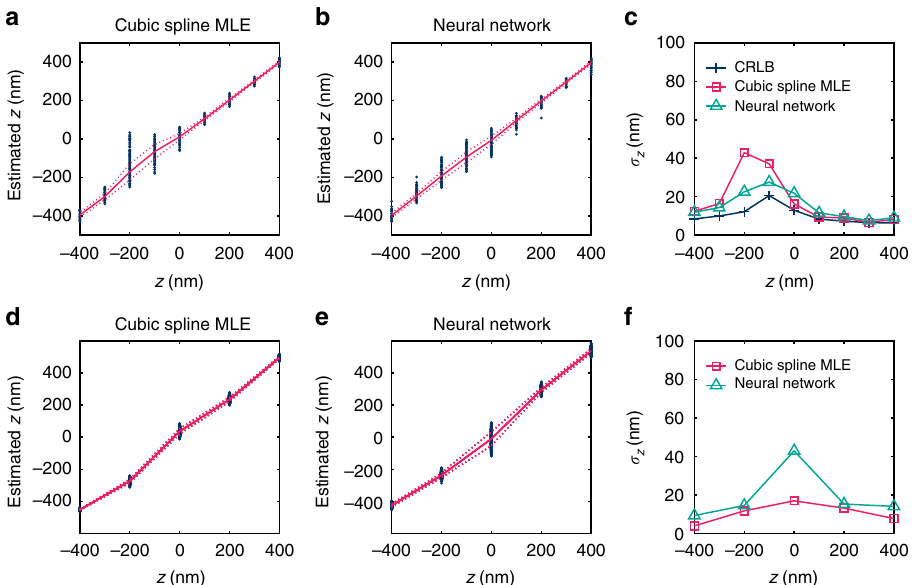
Fig. 3 Comparison of the results of the axial-localization ANN with cubic-spline MLE and with the Cramer-Rao lower bound. a , b Estimated z positions vs. the ground truth over ± 400 nm of the focal center for simulated point sources of 700 nm wavelength at a brightness of 5000 photons, using a MLE with a cubic-spline model and b ANN estimation. The scattered data points represent estimated z positions at each true z position, and the red solid and dash lines give the corresponding mean and standard deviation. c z precision from a , b , compared with the Cramer – Rao lower bound calculated from the cubic- spline model. d – f Corresponding results on experimental images of red fl uorescent beads (typical photon count: ~